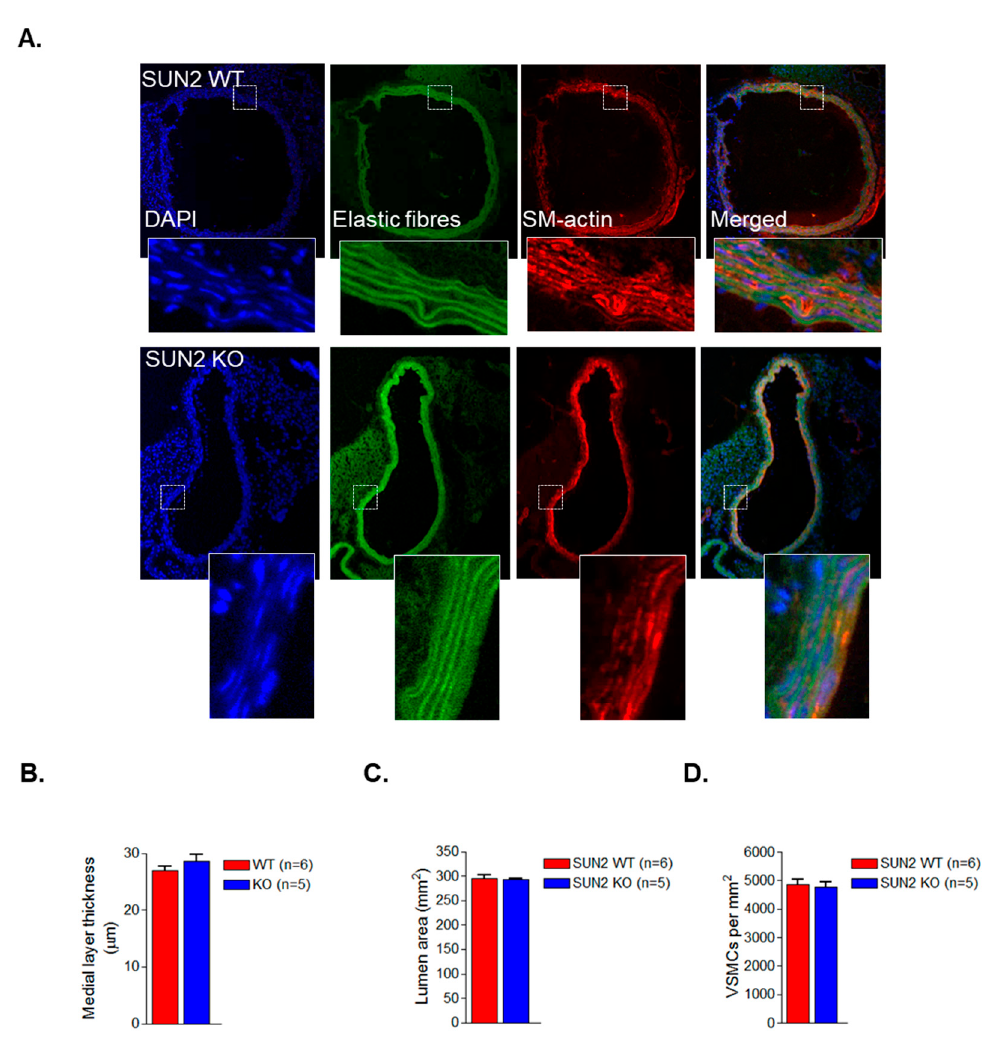
Figure 4. SUN2 KO aortae display normal VSMC organisation. ( A ) Representative IHC images of WT and SUN2 KO aortae stained with DAPI (blue), smooth muscle (sm)-actin (red), and the elastic fibre auto-fluorescence (green). Graphs show ( B ) medial layer thickness, ( C ) lumen area, and ( D ) VSMC number in WT and SUN2 KO aortae.